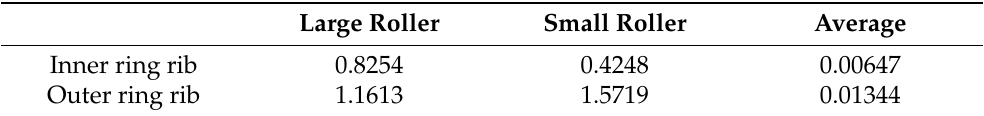
Figure 11. Oil distributions on the large/small roller walls. ( a ) Outer ring rib structure; ( b ) Inner ring rib structure. Table 6. Volume fraction of lubricating oil on the roller wall (%).